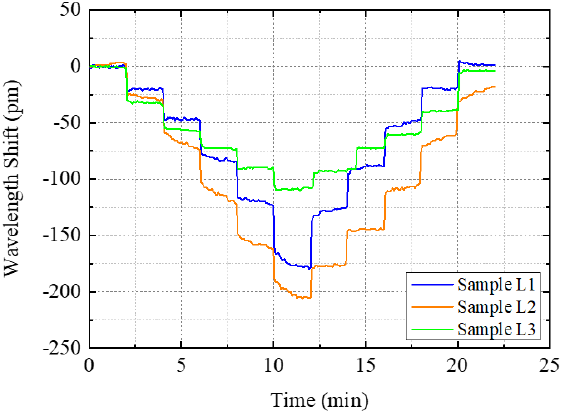
Figure 11. Results of the Bragg wavelength shifts of the samples in the loading and unloading tests.